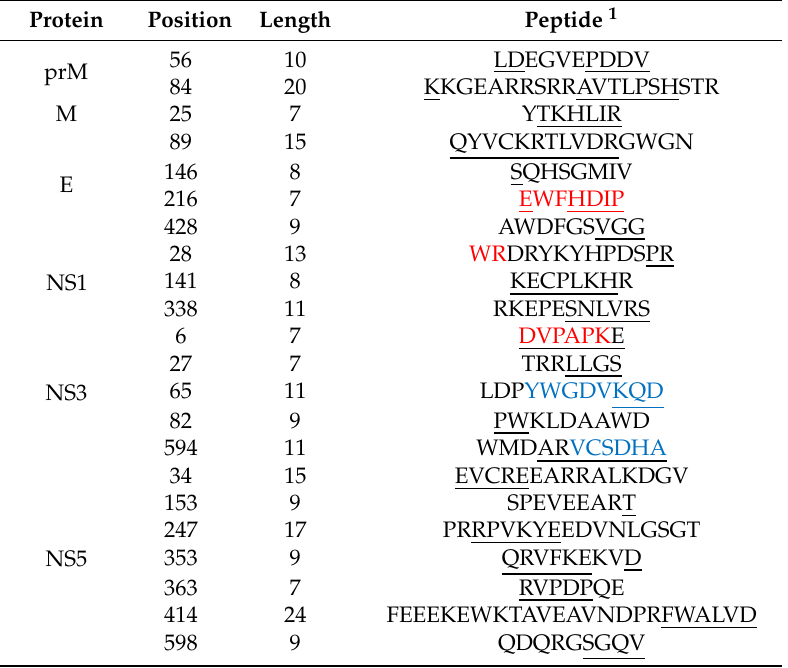
Table 6. Linear epitopes that passed toxicity, conservancy, antigenicity and autoimmunity